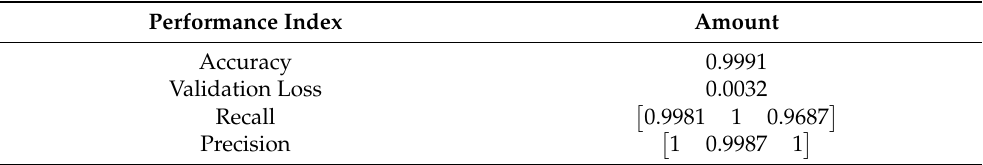
Figure 16. Confusion matrix for the experiment where the combined dataset of both hens is used for training and testing of the LeNet5 model. Table 8. Evaluation of the performance indices when the combined dataset of both hens is used for training and testing of the LeNet5